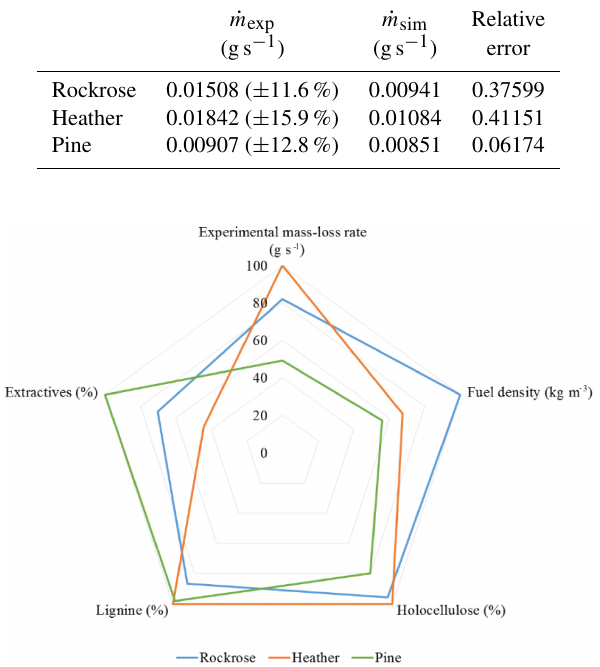
Figure 11. Radar chart of the experimental mass-loss rate and the chemical and structural